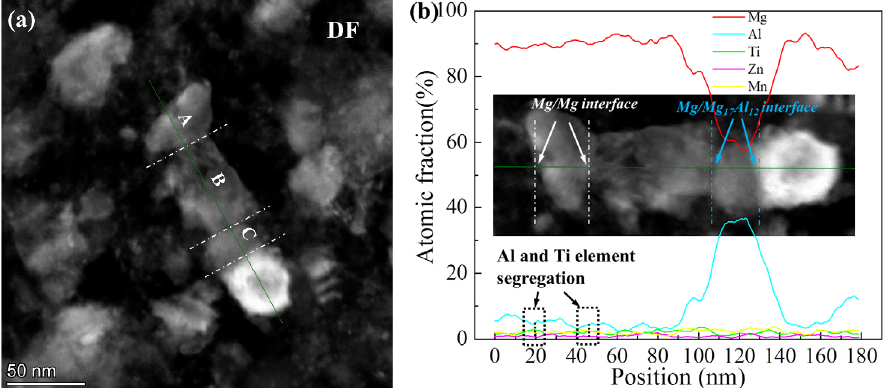
Figure 9. DF image ( a ) and corresponding element content results ( b ) of the milled Ti/Mg-9Al-Zn-0.3Mn composite.